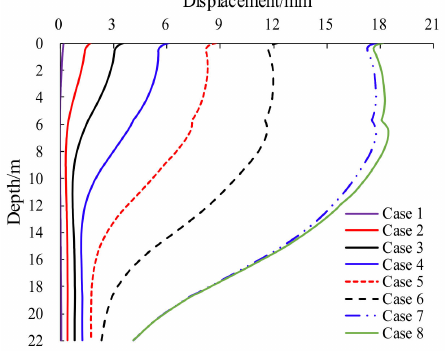
Figure 19. Horizontal displacement of